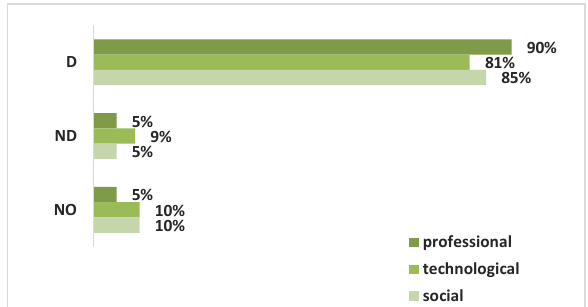
Figure 2. Percentage of answers regarding the social